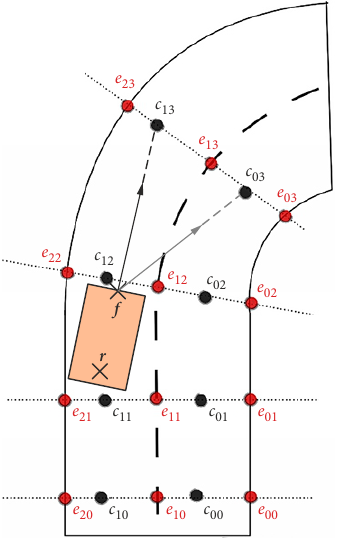
Figure 7. Definition of lane geometry